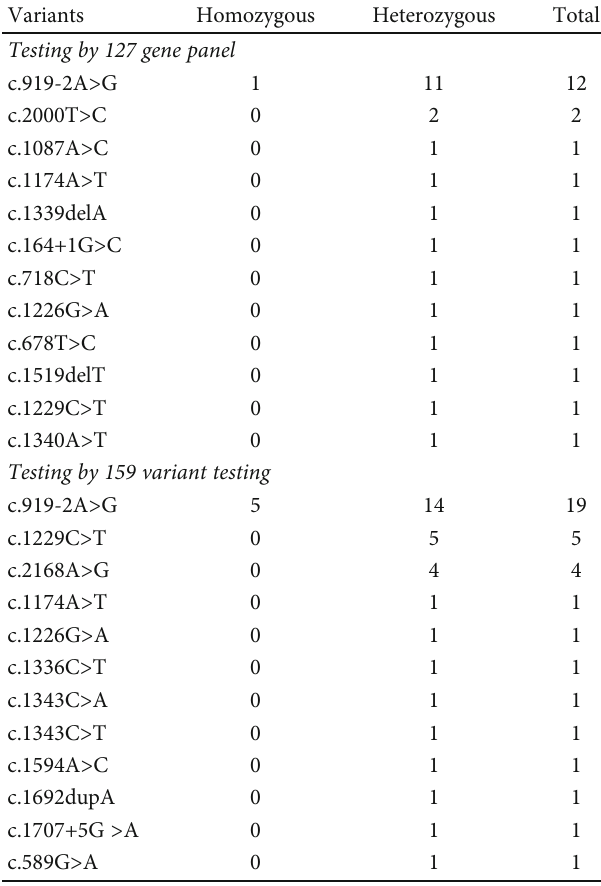
Table 5: Variants frequency in GJB2 gene. Table 6: Variants frequency in SLC26A4